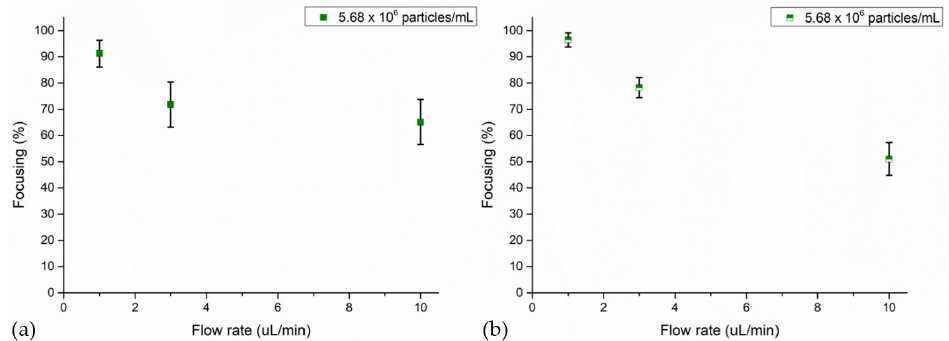
Figure 3. Focusing performance of the BAW device with 4MPs concentrated at 5.68 × 10 6 parti- cles/mL injected at 1 µL/min, 3 µL/min and 10 µL/min: ( a ) UV–Vis characterization and ( b ) image analysis. Experiments were performed by applying 50.59 Vpp at the transducer while the device was actuated at its resonant frequency of 4.623 MHz.